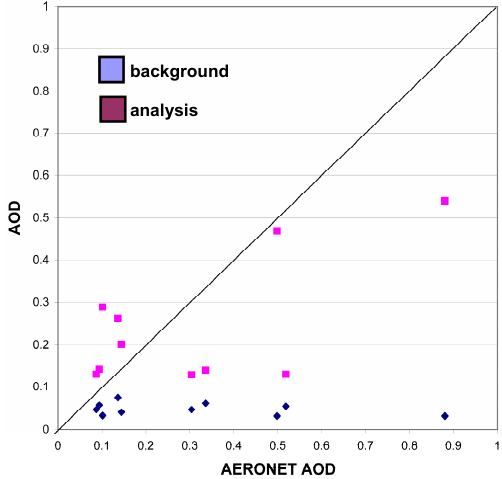
Fig. 5. Background (blue) and analysis (purple) field AOD vs. AERONET AOD measurements for 10 dust outbreak cases in the July to November 2003